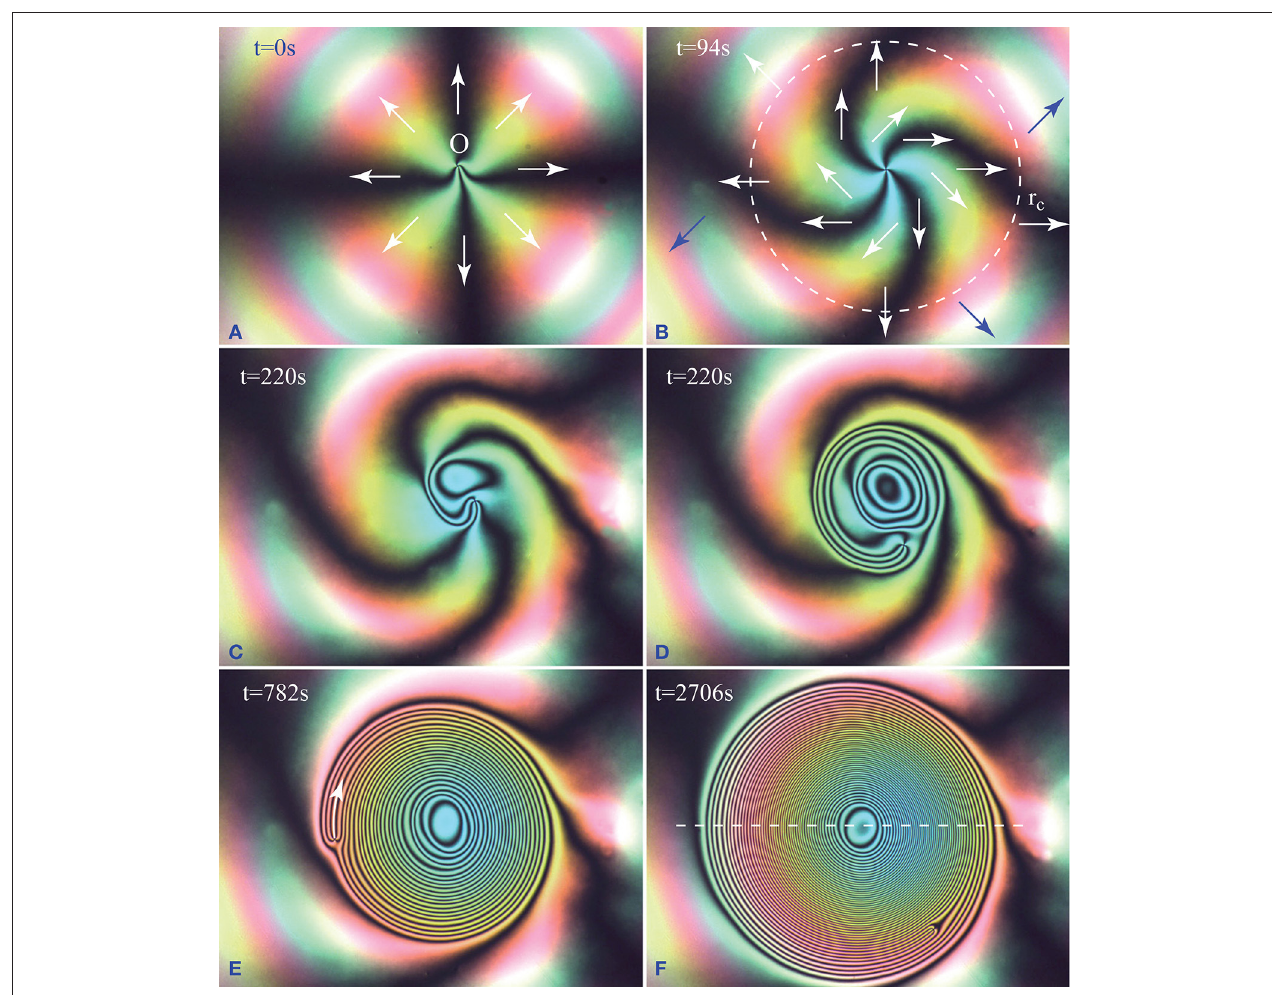
FIGURE 8 | Cladis-Brand state C-B1 obtained by winding of the dowser texture in the Circular Dowsons’ Collider. (A) Initial radial configuration of the dowser field. (B) Beginning of the winding in the anticlockwise direction. The initial configuration is slightly perturbed by a - π/ 2 rotation in the center. (C) The first isogyre nucleated in the center is growing. (D,E) Continuation of the winding. Remark: As for energetic reasons the dowson d + cannot change easily its configuration, it conserves its phase staying at the periphery of the growing target pattern. (F) Dynamically stable Cladis-Brand state C-B1. The continuing phase growth in the center of the target pattern is absorbed by the orbiting dowson which acts as a phase